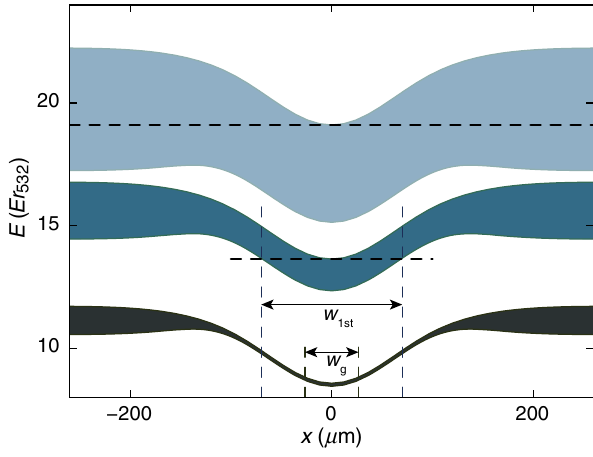
FIG. 7. Spatial band structure of the lowest three bands of the longitudinal ( x ) lattice along the x direction at y , z ¼ 0 . The ground band is illustrated in black, the first longitudinally excited band in dark blue, and the second longitudinally excited band in light blue. The structure emerges because of the Gaussian shape of the dipole and lattice beams. The red line illustrates the pure trapping potential. The dashed horizontal lines illustrate that atoms in the second excited band can tunnel out of the system, but atoms in the first excited band remain trapped. The cloud size in the ground band is indicated by w , which corresponds to the g 1 =e 2 width of a Gaussian fit. For the first excited band, the indicated size w 1 is derived from the band structure calculation, st which agrees well with the result of an in situ